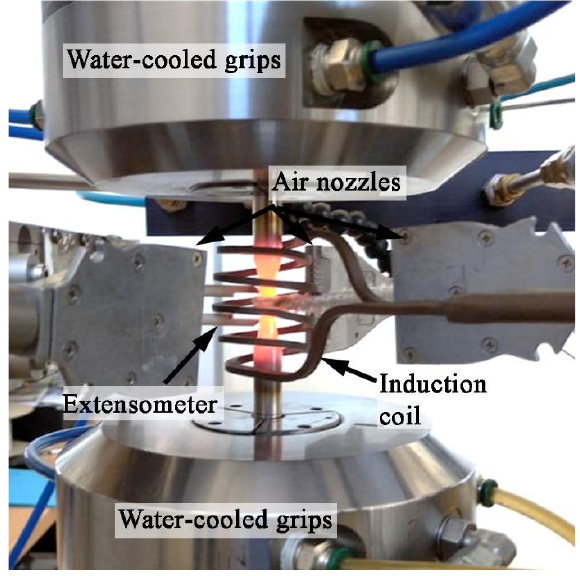
Figure 4. TMF experimental setup showing the specimen heated to 900 °C, water-cooled hydraulic grips, Cu induction coil, air nozzles for specimen cooling, and extensometer.